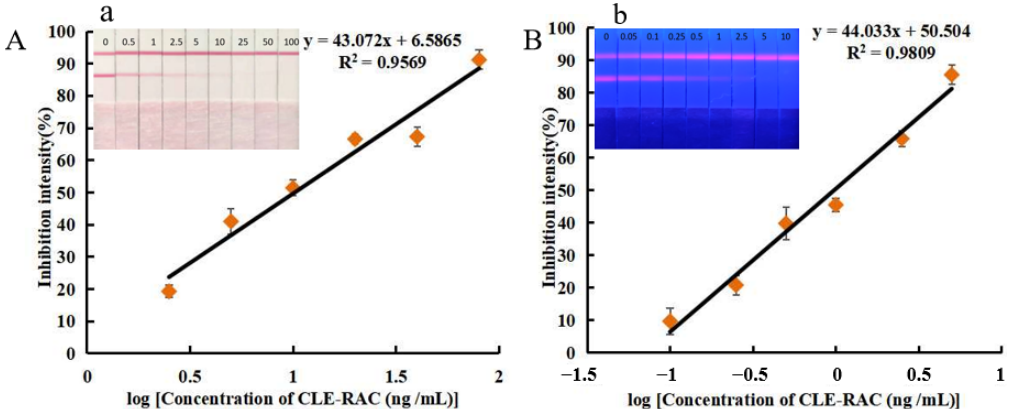
Figure 4. Detection in EuNP-FLFIA and CG-LFIA. ( A ). The standard curve for CLE+RAC (1:1) by CG-LFIA. a. Physical diagram of CG-LFIA for CLE-RAC sensitivity detection. ( B ). The standard curve for CLE+RAC (1:1) by EuNP-LFIA. b. Physical diagram of EuNP-FLFIA for CLE-RAC sensitivity detection.